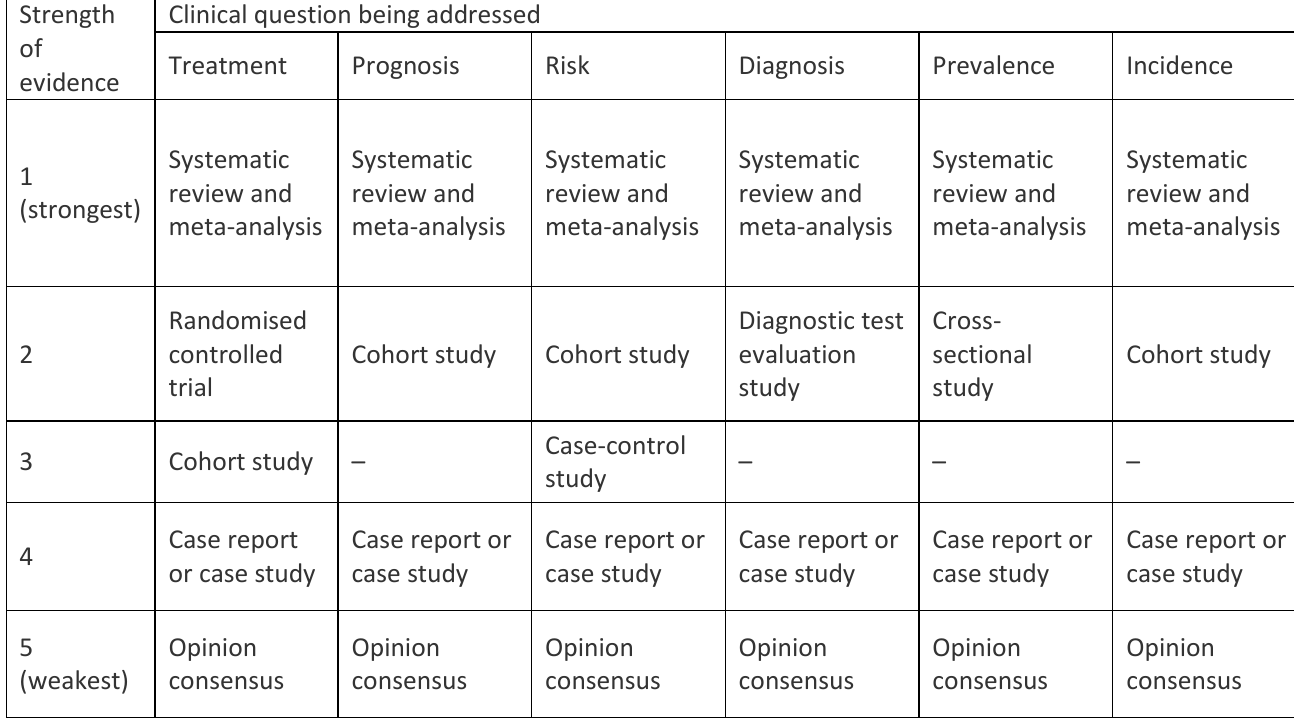
Table 1: Level of evidence table, adapted from the Oxford Centre for Evidence-Based Medicine’s levels of evidence